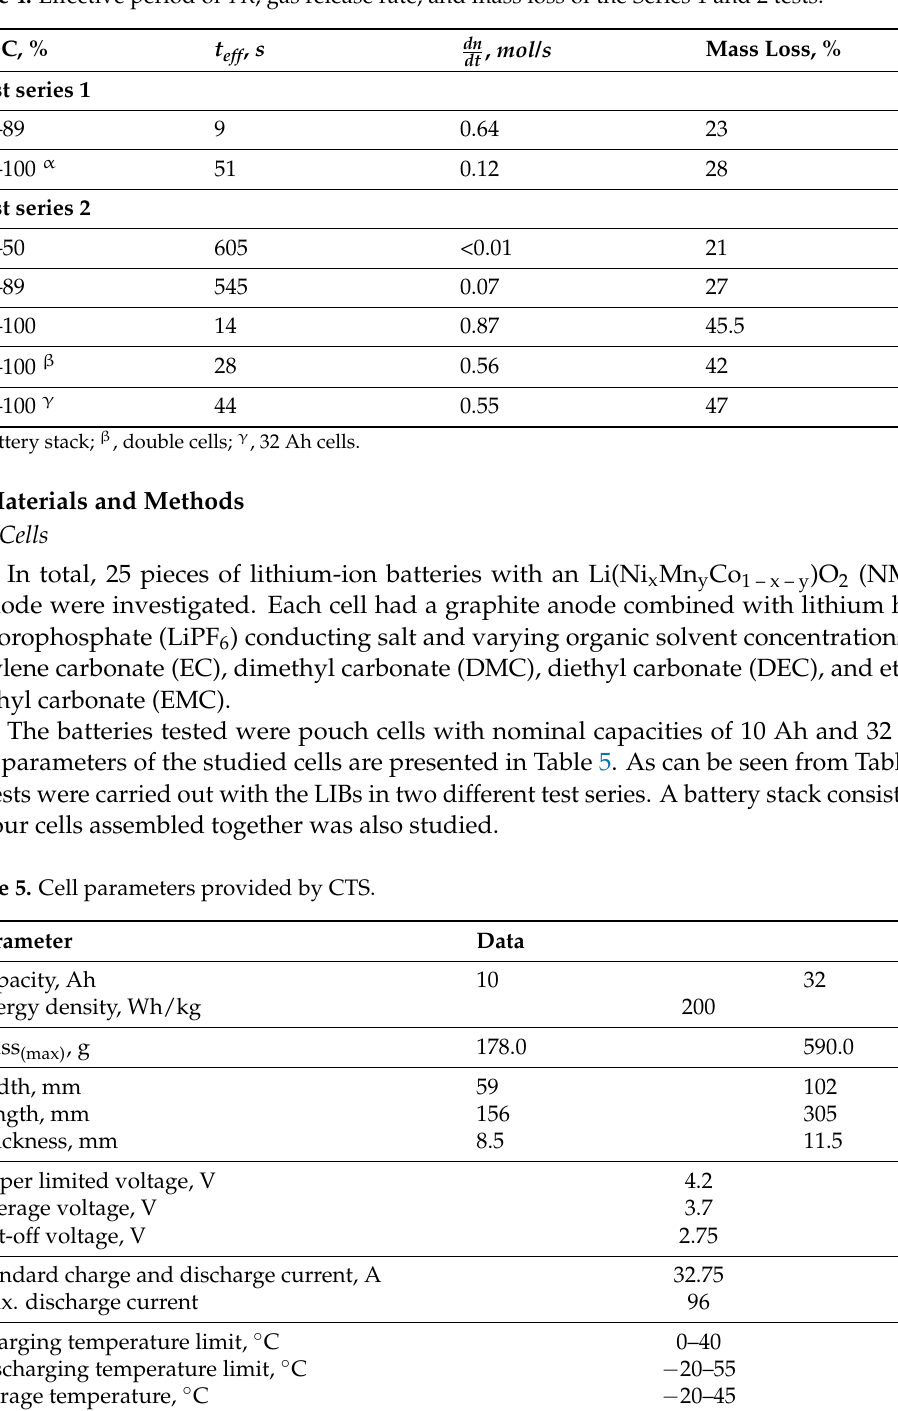
Table 4. Effective period of TR , gas release rate, and mass loss of the Series 1 and 2 tests.